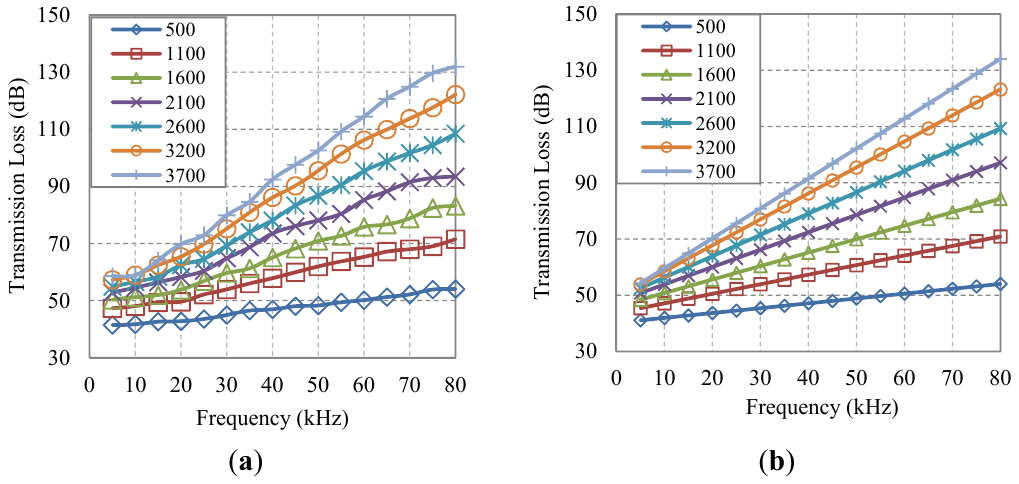
Figure 5. Average transmission loss vs. frequency; ( a ) Bellhop, and ( b ) SPM